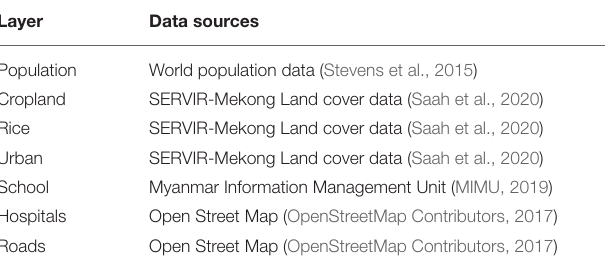
TABLE 1 | Data sources for the Flood Exposure Index (FEI; Equation